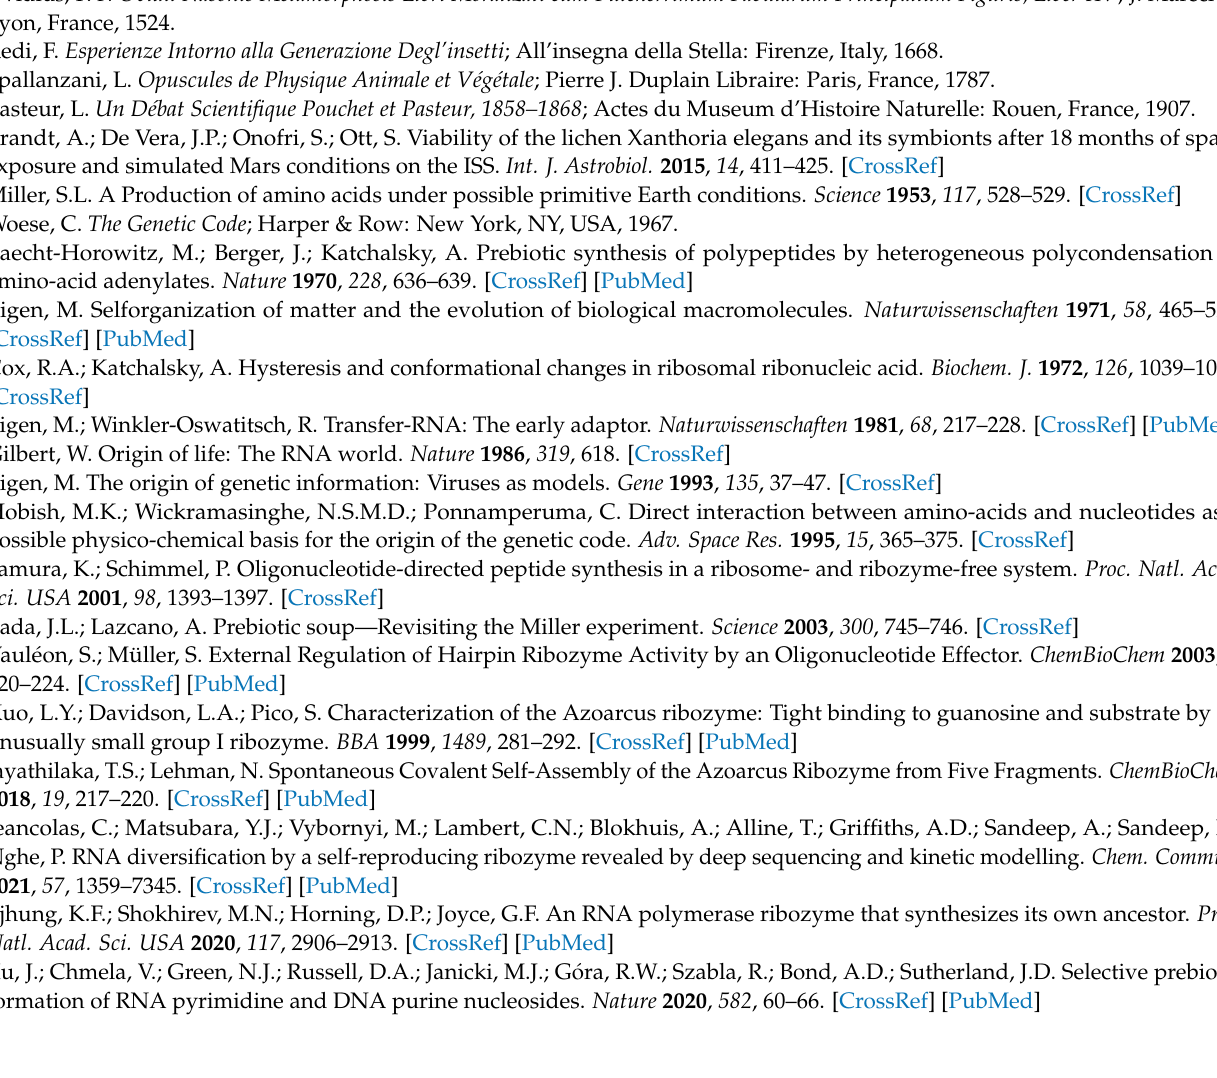
Table S1: tRNA-GlyGCC of 70 Archaea; Table S2: tRNAs from various species; Table S3: Percentage of AL-pentamers in Methanococcus voltae genes coding for proteins involved in ribosomal translation; Table S4: rRNAs and genes coding for rproteins from different species; Table S5: Glycyl-tRNA ligase sequences from different species; Table S6: Nucleolin sequences from different species; Table S7: 5S of Archaea with their